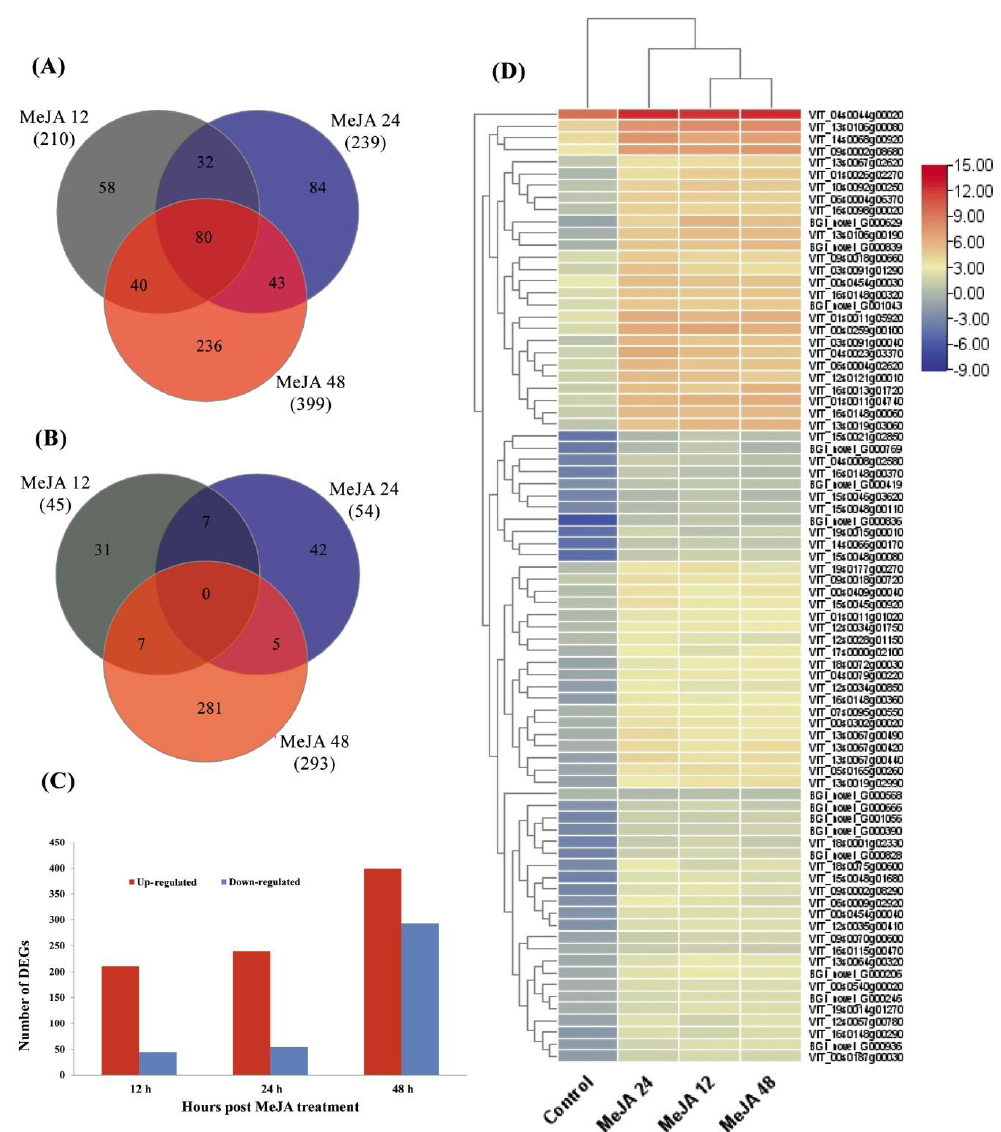
Figure 1. Overview of RNA-seq data with the application of MeJA at different time courses. ( A ) Venn diagram elucidating the number of genes upregulated by MeJA treatment over the different time points. ( B ) Venn diagram elucidating the number of genes downregulated by MeJA treatment over the different time points. ( C ) Total number of transcripts that was significantly up- or down- regulated in response to MeJA treatment. Log2 FC ≥ 1 or ≤ −1 and p < 0.01 FDR. ( D ) Heatmap of common upregulated genes found at all time points.